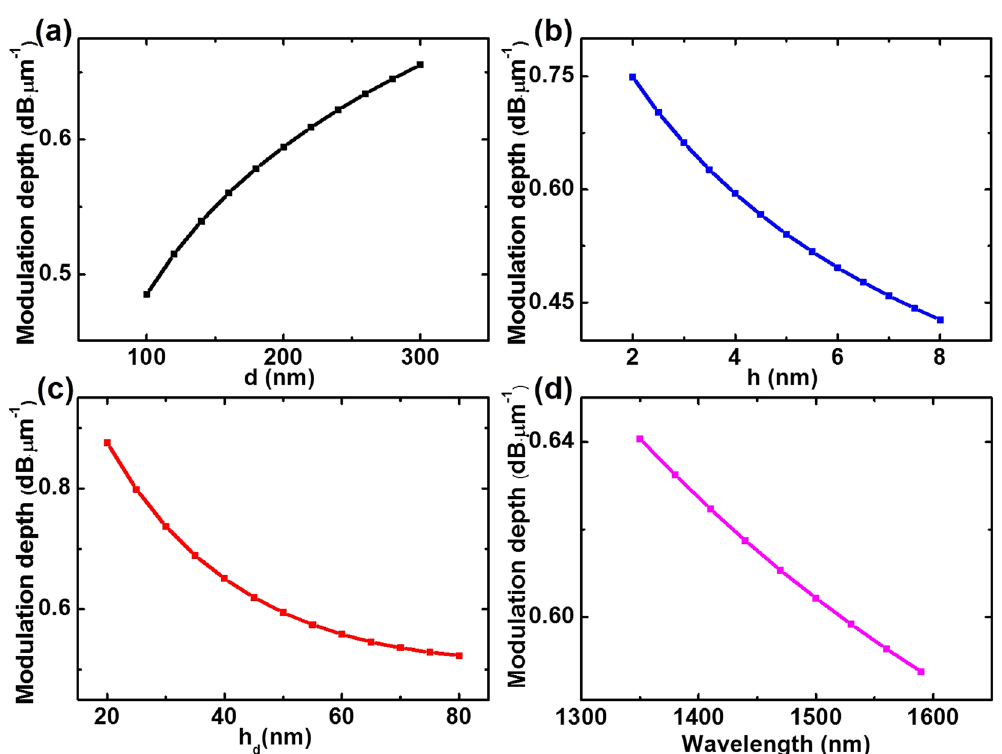
Figure 6. The modulation depth of SGHPM varies with the cylinder diameter d, the dielectric gap thickness h and the silicon slab thickness h d , respectively. ( a ) The cylinder diameter d varies from 100 to 300 nm where h = 4 nm and h d = 50 nm. ( b ) The gap thickness h varies from 2 to 8 nm where d = 200 nm and h d = 50 nm. ( c ) The silicon slab thickness h d varies from 20 to 80 nm where d = 200 nm and h = 4 nm. ( d ) The modulation process of SGHPM is achieved for a broad band of wavelengths from 1350 nm to 1600